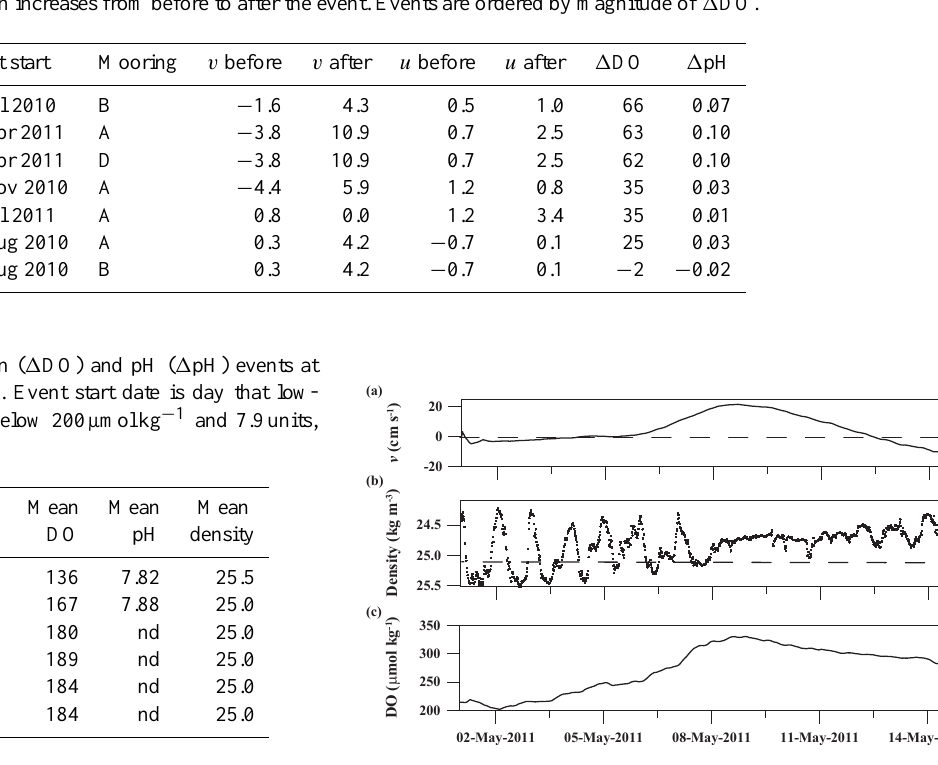
Fig. 3. Event-scale increases in dissolved oxygen (DO) following the intrusion of high-density seawater ( σ > 25.1kgm − 3 ) at 7m be- low the surface at mooring D. (a) Mean alongshore current velocity between 5 and 30m at the Del Mar buoy, (b) time series of den- sity and (c) time series of 2-d smoothed DO from 26 April 2011–16 May 2011. Density scale is reversed. Positive alongshore velocities indicate poleward flow.